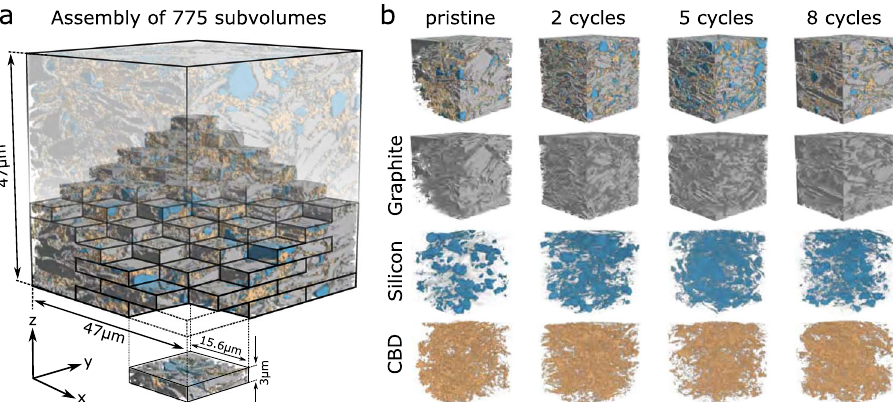
Fig. 6 Deep Learning Segmentation. Illustration highlighting that for each sample, the deep learning approach is applied to 775 subvolumes ( a ), which, once segmented, are reassembled. The multiphase segmentation ( b ) for pristine samples and samples cycled twice, fi ve times, and eight times enable a number of different microstructural analysis.